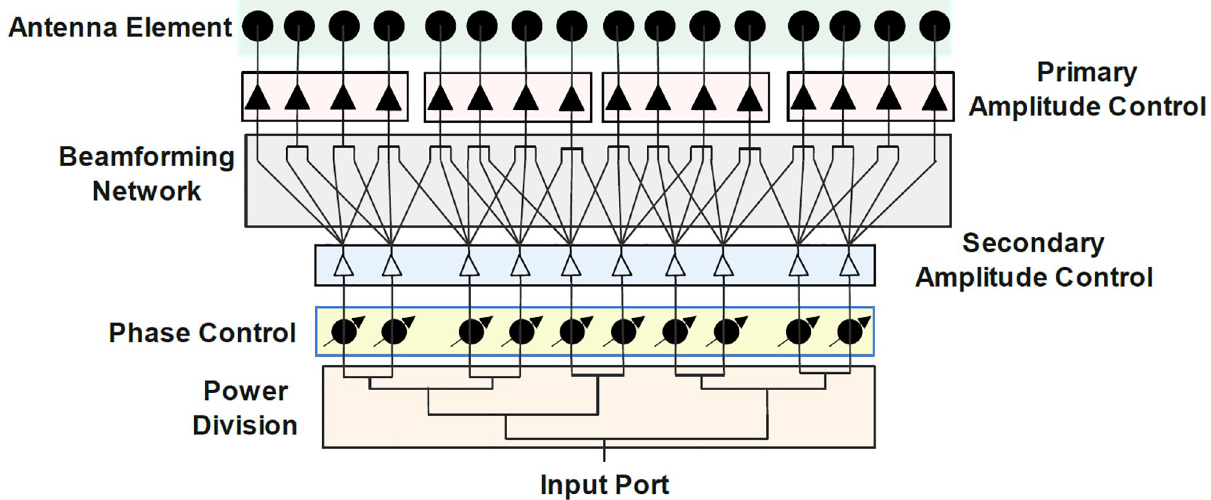
Fig 7. Schematic of the suggested ROSA network for 16-element linear array consisting of power division, phase control, amplitude control of primary and secondary array.